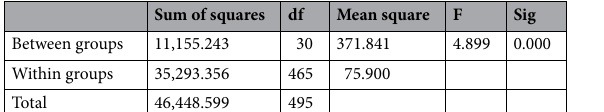
Sum of squares df Mean square